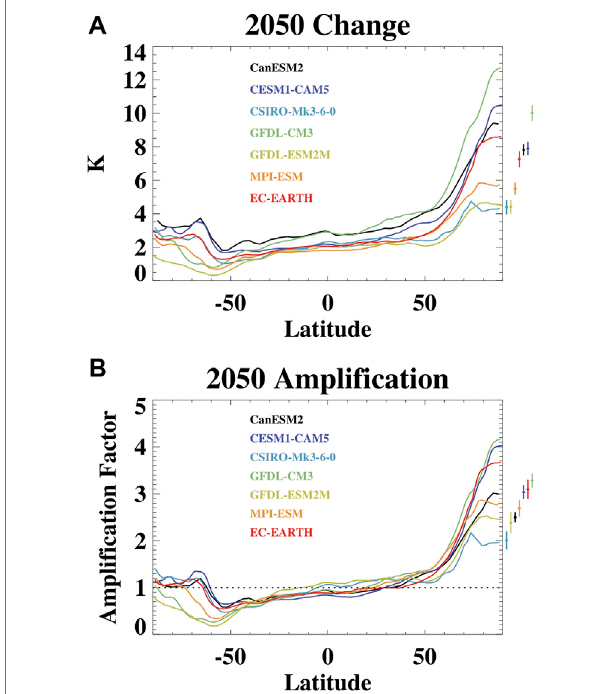
FIGURE2|(A) Thezonalmeanchangeinsurfaceairtemperatureforthe 2050s relative to the reference period and (B) The ampli fi cation factor of that warming, de fi ned as thezonal temperature change relative tothe global mean change. The diamonds shown to the left indicate the ensemble mean 70 – 90N values for each model with the whiskers indicating one standard